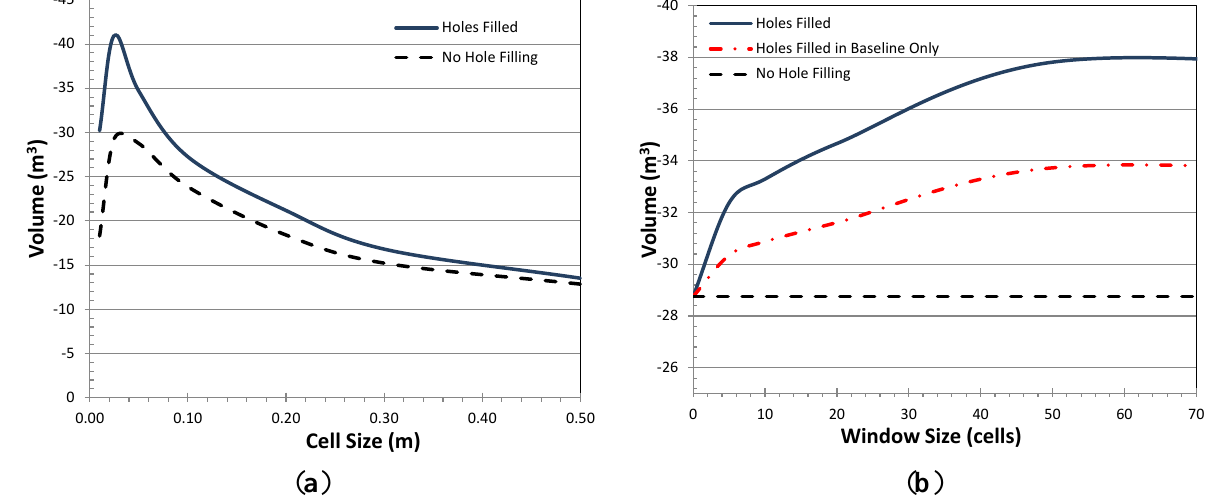
Figure 16. ( a ) Comparison of calculated erosion volumes for various resolutions and with (HF) and without (NHF) hole filling for Site B between 2013 and 2014 . Note that the hole filling window size was adjusted for each cell size analyzed such that it filled smaller holes, but did not fill excessively large holes; ( b ) Comparison of rockfall volumes for Site A with varying hole filling search window size . For this analysis, a constant cell size of 0.05 m was used . Note that at a window size of 50 (2.5 m), all holes are filled so the volume does not vary significantly below that